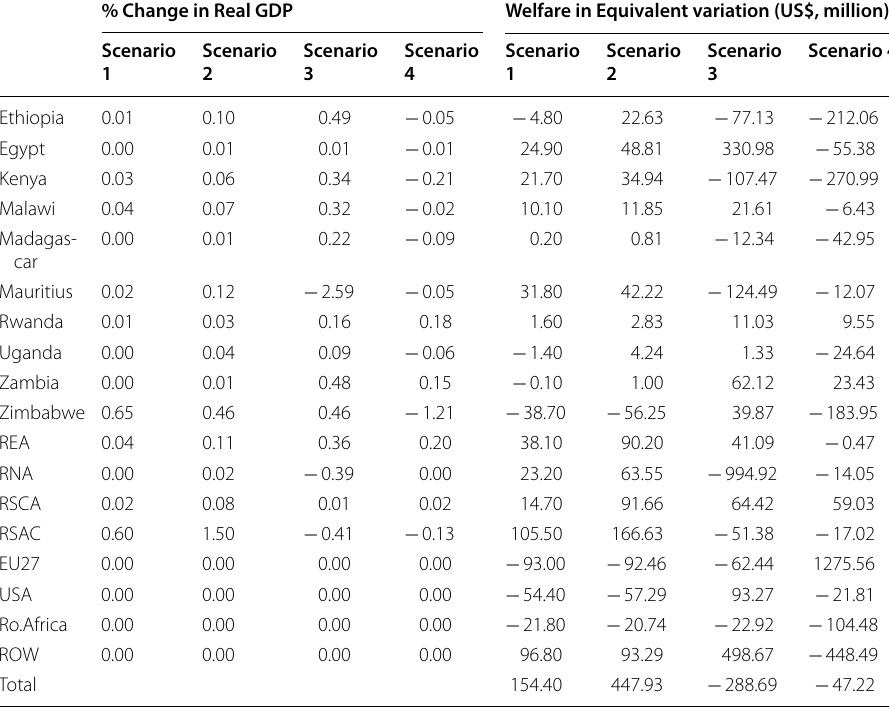
Table 6 Changes in real GDP and welfare, by region. Source: Model Simulation